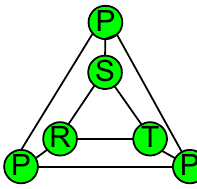
Figure 6. The canonical GTD ecosystem with the P node “watchdogs” for its health.